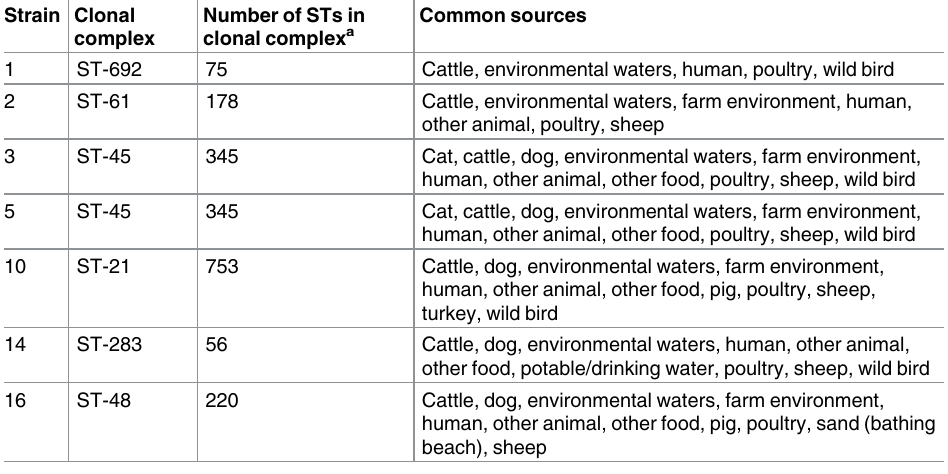
Table 3. Clonal complexes of Campylobacter sequence types found in feces from bats and common sources of iso- lates within the MLST database